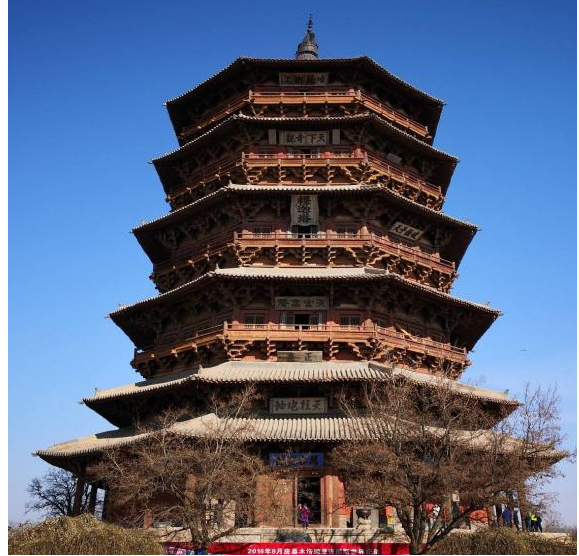
Figure 2. The Shaka Pagoda.